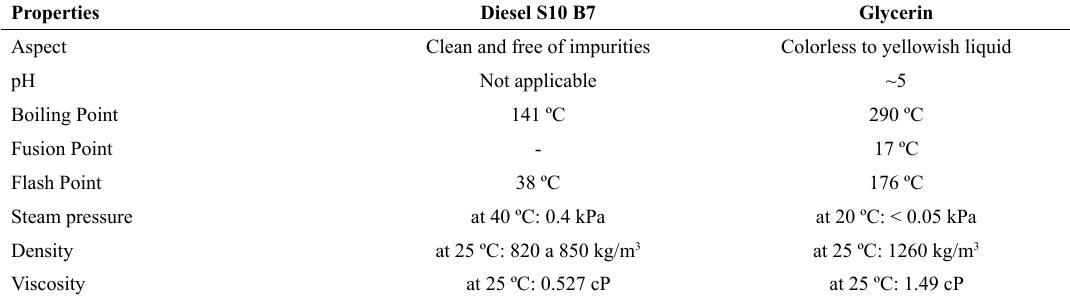
Table 2. Physical-chemical properties of diesel S10 B7 and